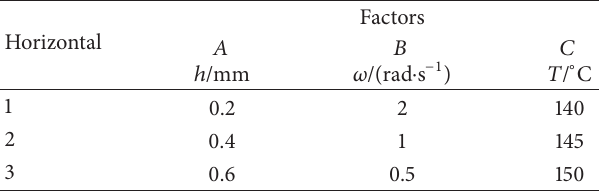
Table 1: Three factors and 3 horizontal test